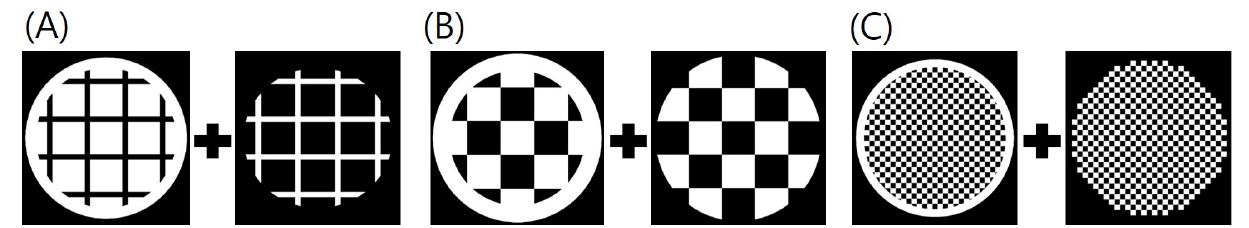
Figure 16. Pa tt erned curing images: ( A ) Square and line pa tt ern (3 × 3 mm square and 0.1 mm line Figure 16. Patterned curing images: ( A ) Square and line pattern (3 × 3 mm square and 0.1 mm line pa tt ern); ( B ) big square pa tt ern (3×3 mm square pa tt ern); ( C ) micro square pa tt ern (0.5 × 0.5 mm pattern); ( B ) big square pattern (3 × 3 mm square pattern); ( C ) micro square pattern (0.5 × 0.5 mm square pa tt ern). square